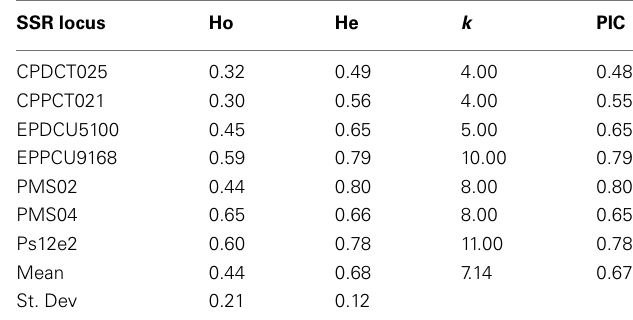
Table 5 | SSR loci from different Prunus species analyzed in the sweet cherry cultivars studied, number of alleles obtained ( k ), observed (Ho), expected (He) heterozygosity, and polymorphism information content